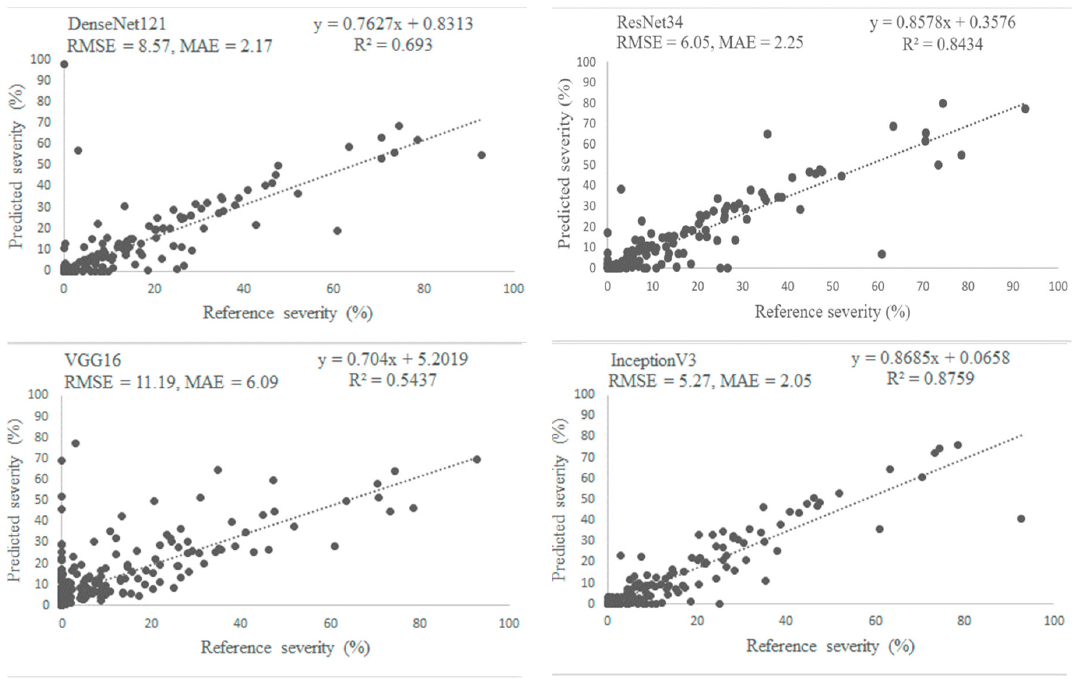
Figure 6. Scatter plots of the first-order regression line for the relationship between reference severity obtained from reference masks (manually annotated) and the severity estimated by using the FPN model and different backbones.